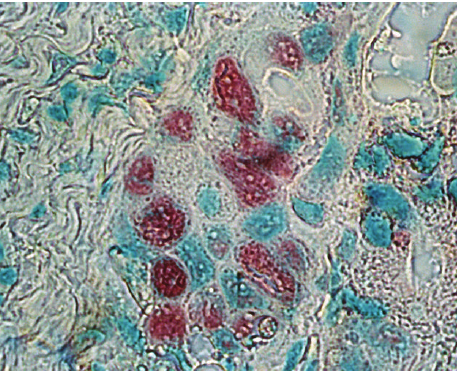
Figure 4: p53 immunostaining in malignant breast epithelial cells. Almost all neoplastic cell nuclei reveal strong accumulation of the p53 protein. p53-positive cells have red nuclei and a green staining underlines nuclei of unlabelled cells (frozen section, alka- line phosphatase antialkaline phosphatase—APAAP—technique, monoclonal antibody Pab240, fast red chromogen, counterstained with methyl green, × 250).